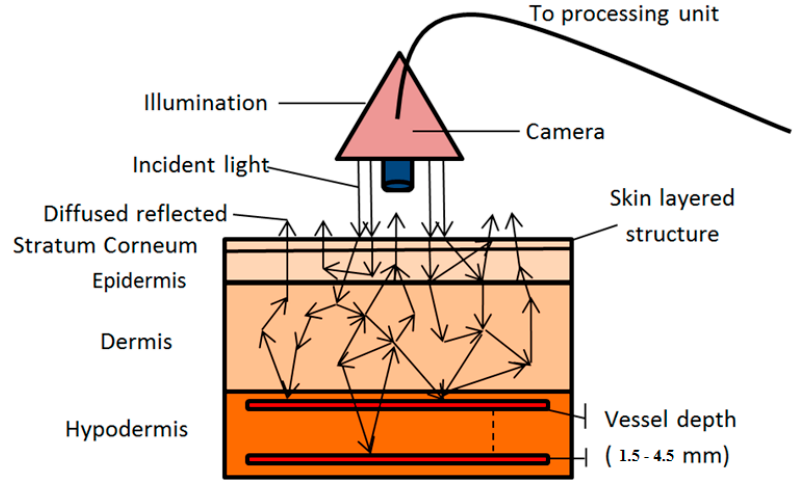
Figure 1. Setup to measure diffused reflectance in four-layers skin model with varying vessel’s